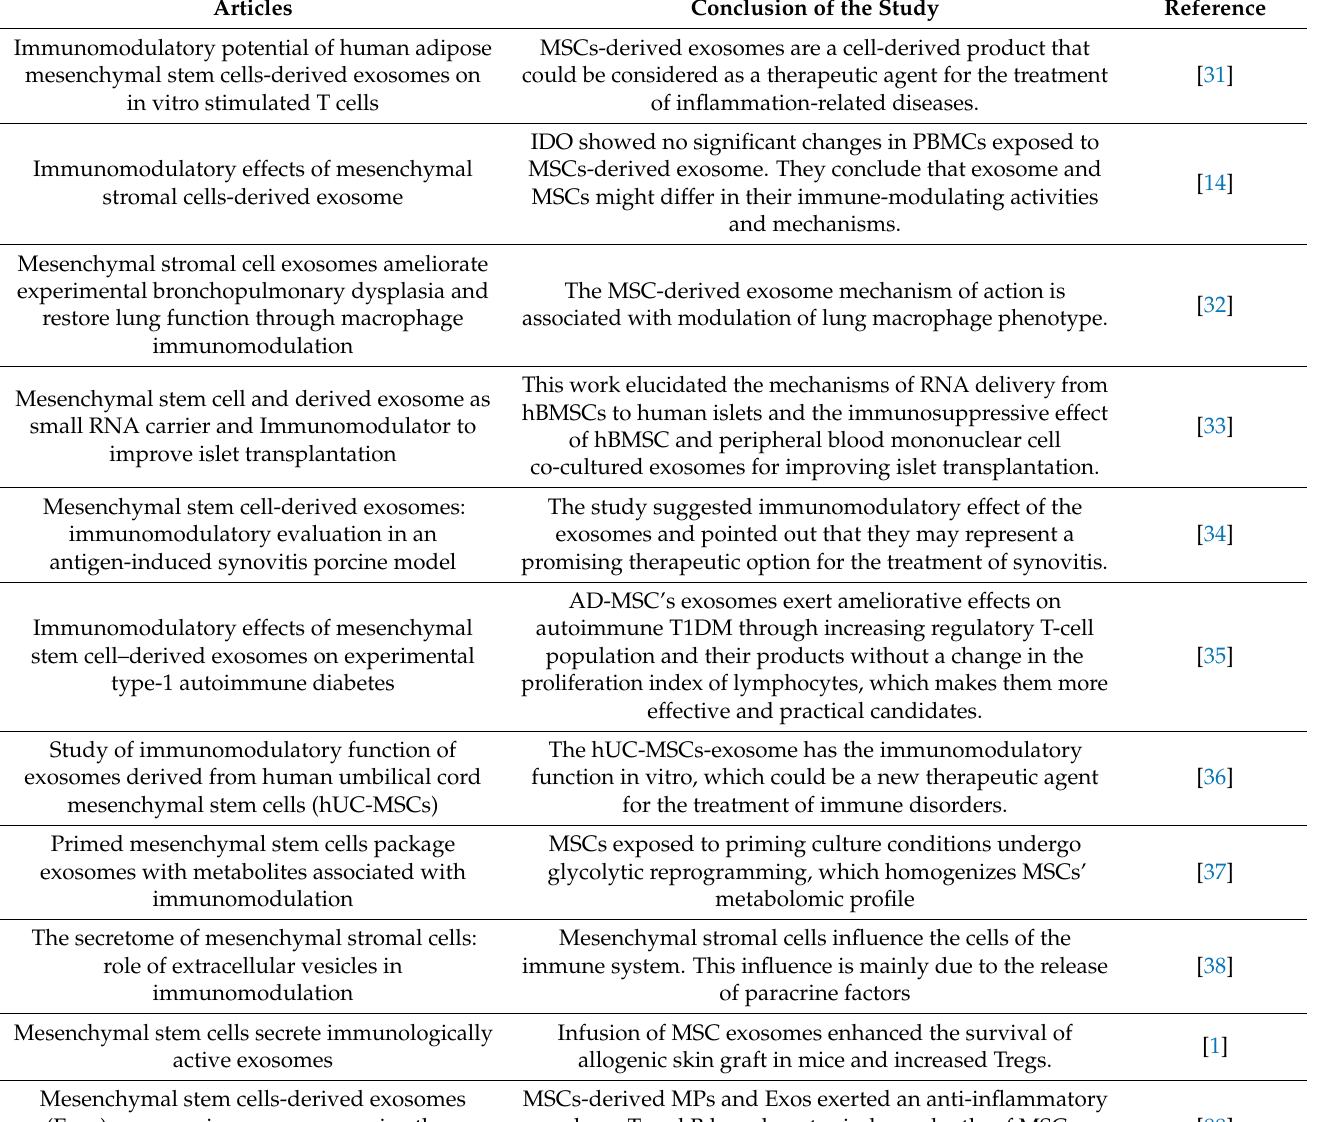
Table 6. Studies showing immunomodulatory role of mesenchymal stem cells-derived exosomes.